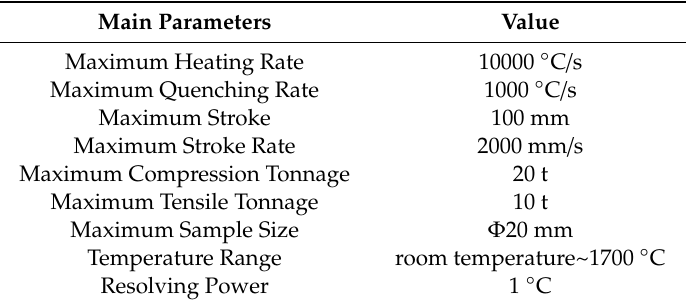
Table 2. Main parameters of Gleeble-3800 thermal simulator.